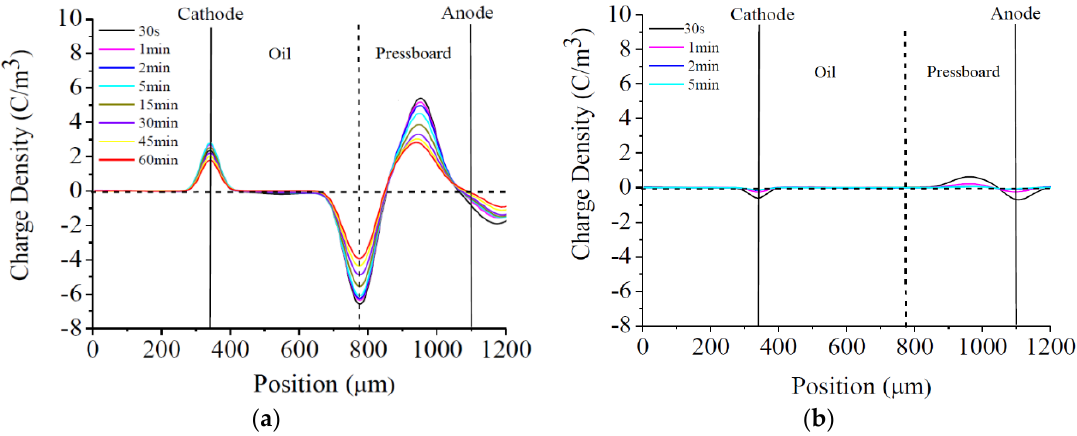
Figure 13. Space charge decay of new oil gap and oil impregnated pressboard (( a ) new oil with 0.68% water content, ( b ) aged oil with 3.83% water content) [27].